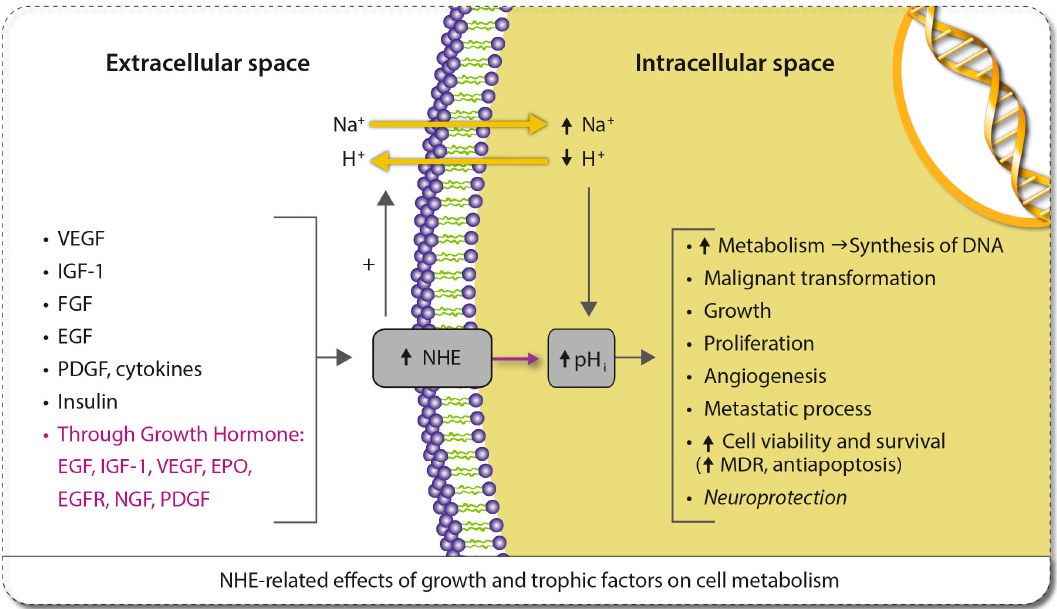
Figure 1. Growth and trophic factors, and cytokines that are involved in the carcinogenic expression and / or hyperactivity of NHE1 and the consequent increase in pH (modified and updated from ref